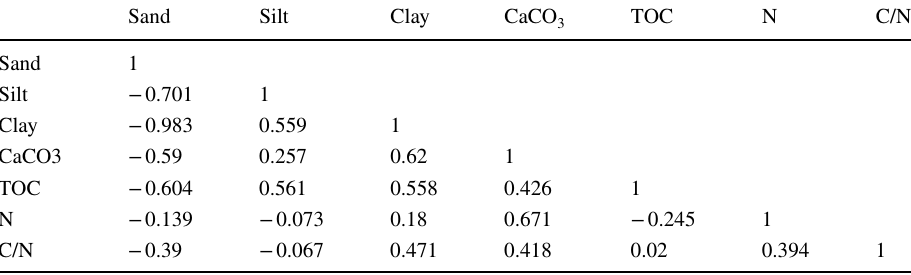
Table 2 Correlation matrix of the grain size and organic matter, CaCO 3, TOC, N and C/N in Akkulam-Veli lake surface sediment